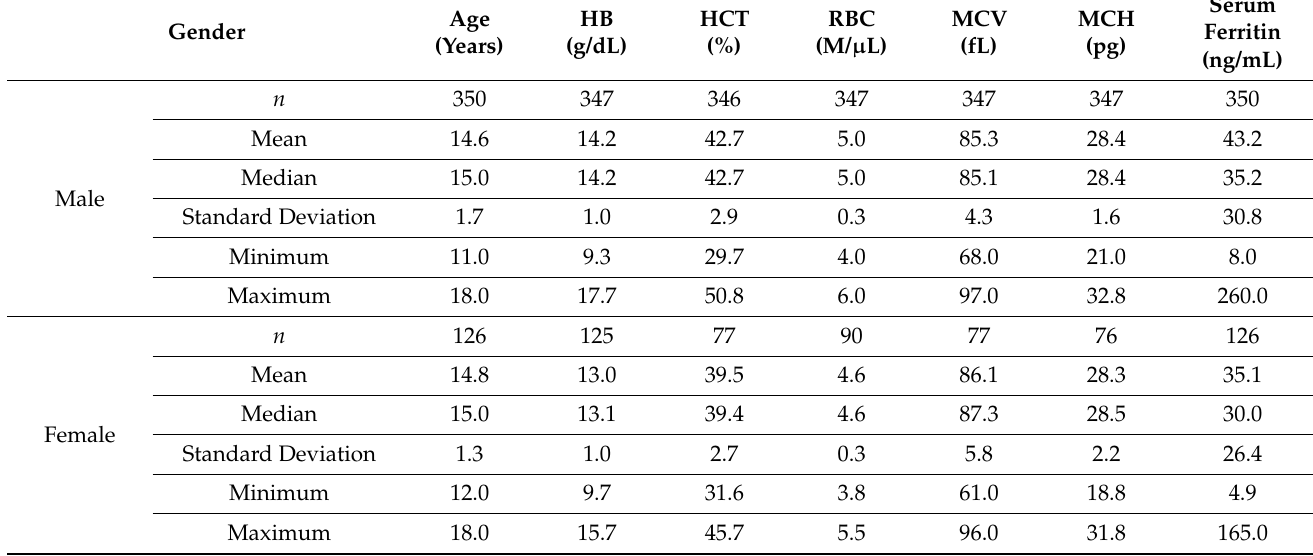
Table 1. Gender, age, red blood cell parameters, and iron status